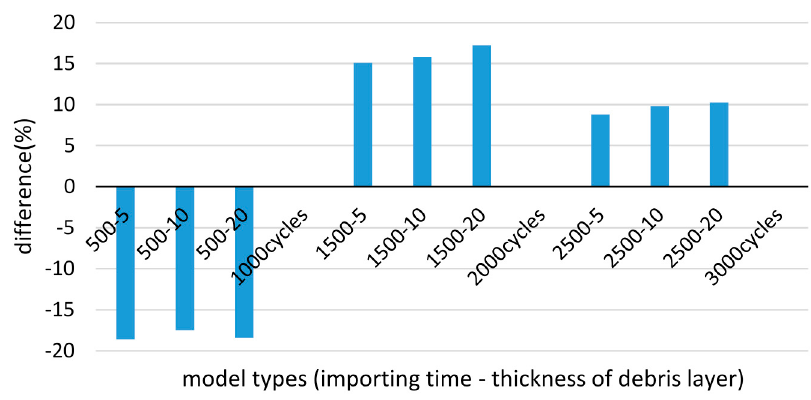
Figure 17. Difference of wear damage compared to the case of basic model, after 1000 cycles, 2000 cycles and 3000 cycles.